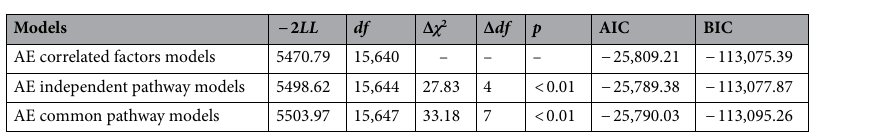
Table 4. Fit statistics for the multivariate